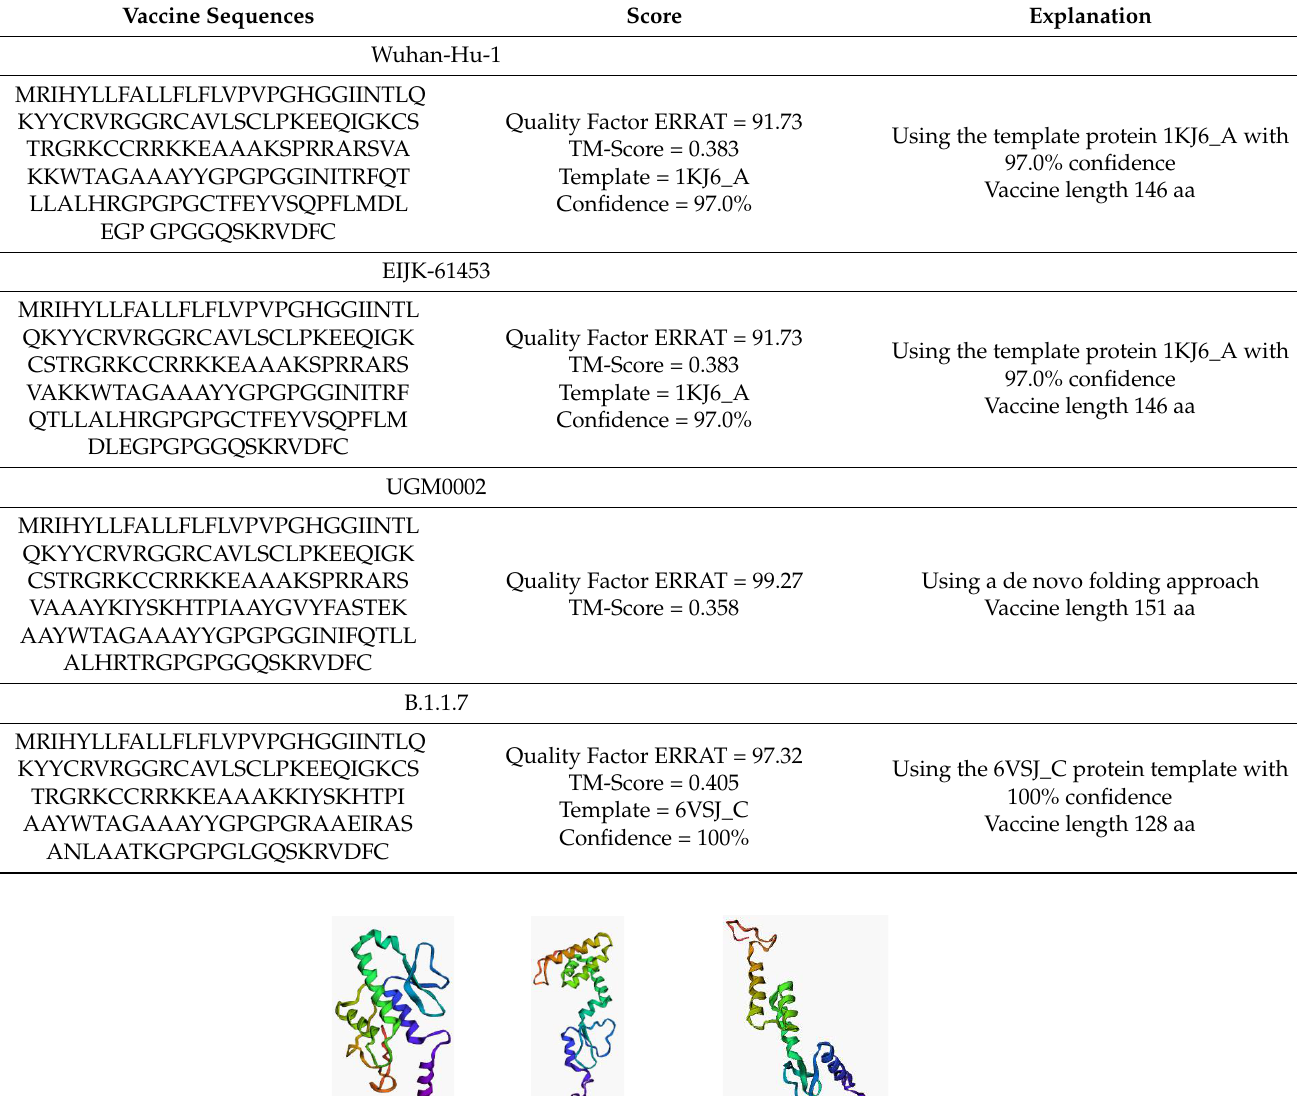
Table 6. List of the best multi-epitope vaccines for each sequence.